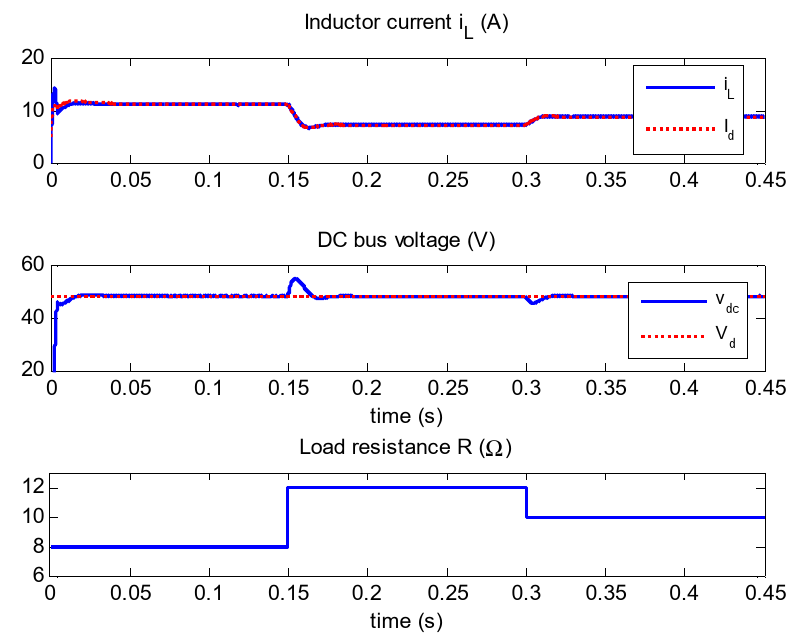
Figure 19. Robustness of the cascade controller in the presence of load resistance uncertainties.